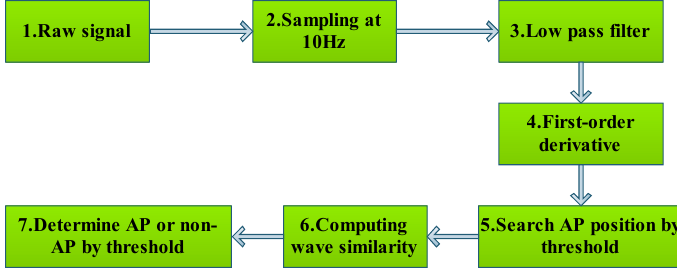
Figure 1. Processing flow of recognizing and classifying AP.